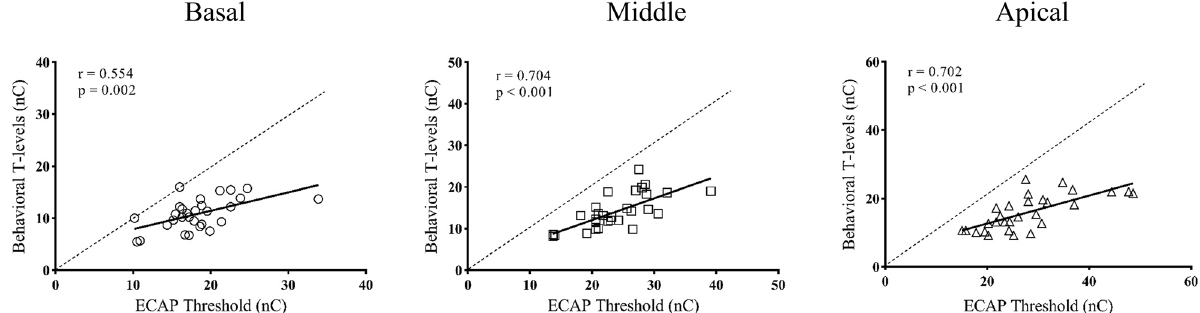
Figure 3. This figure shows a scatter plot of ECAP thresholds versus behavioral T-levels at the “Basal”, “Middle” and “Apical” electrode locations. The dotted line indicates that the ECAP threshold was equal to the behavioral T-level; the solid line represents the correlation between ECAP thresholds and behavioral